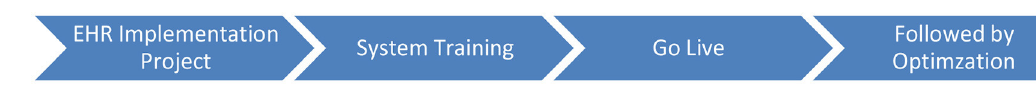
FIGURE1 Prevalent IT change methodology for EHRs.